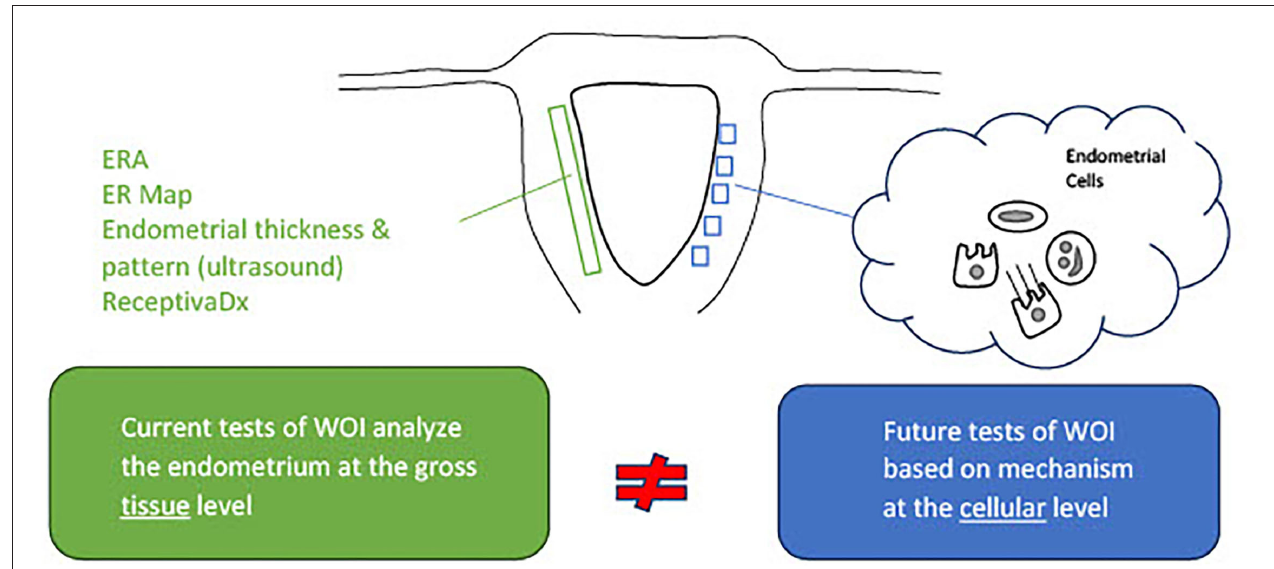
FIGURE 2 | Current tests of the window of implantation are not based on full knowledge of the mechanisms regulating the endometrial receptivity. Activities of the endometrial cells underly the processes essential to the entry and maintenance of the window of implantation. Commercial tests of window of implantation, however, do not analyze the endometrium at the cellular level necessary to investigate the status of